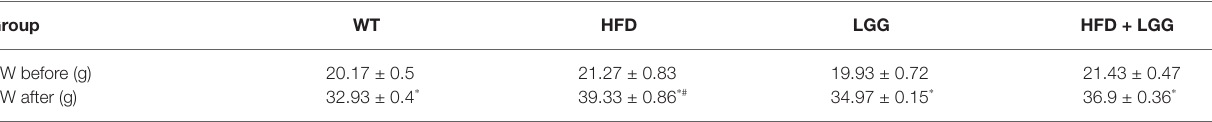
TABLE 2 | Body weight measurements, before and after treatment, presented as mean ± SD. Group